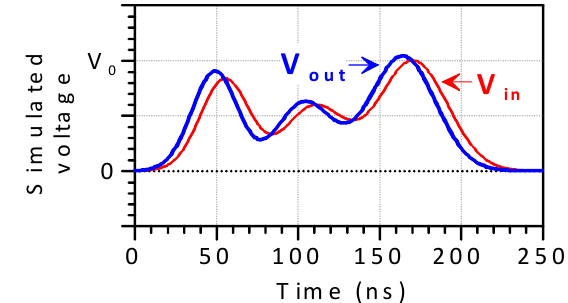
Figure 9: NGD circuit transient analysis